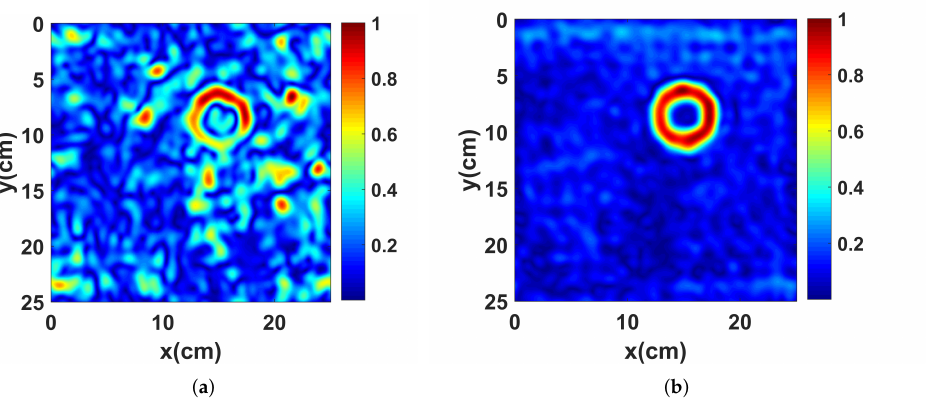
Figure 6. HSR images obtained from the adaptive SVD and denoizing autoencoder on Scene II. ( a ) Result of the adaptive SVD. ( b ) Result of the denoizing